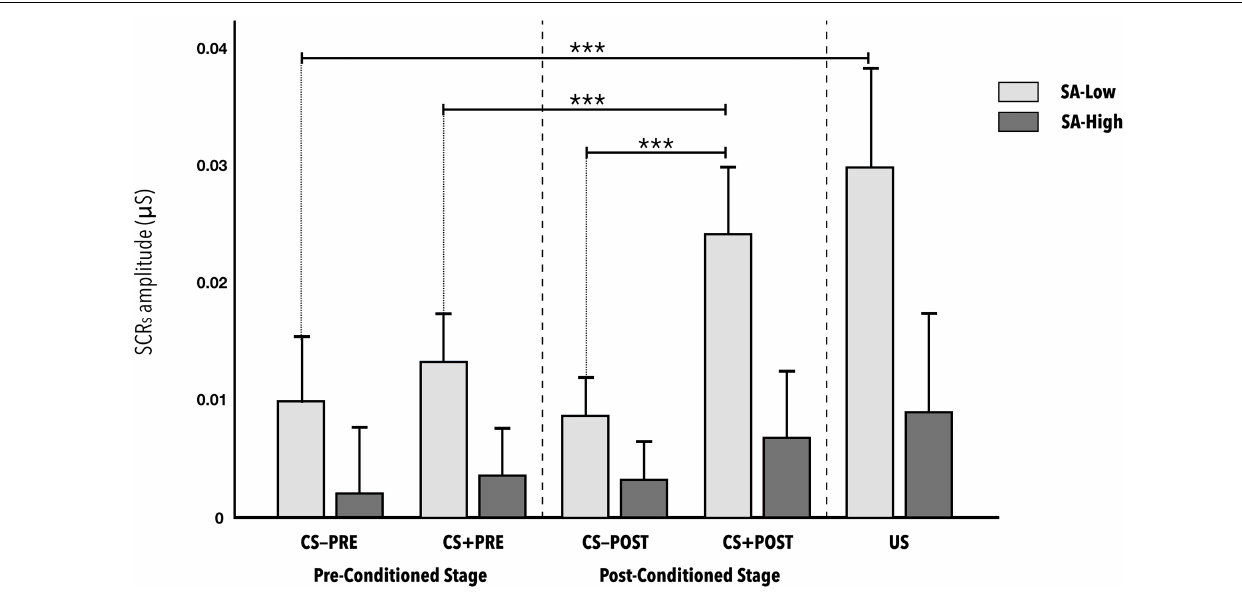
FIGURE 2 | Mean amplitudes of skin conductance responses to the CS − , CS+, and US stimuli during the vicarious phase of the fear conditioning paradigm, according to reported level of state anxiety. CS − and CS+ responses are distinguished as either before (pre-conditioned stage) or after (post-conditioned stage) the US was presented. No statistically significant differences were observed between CS-PRE vs. US ( d = 0.747), between CS + PRE vs. CS + POST ( d = 0.639), or between CS-POST vs. CS + POST ( d = 1.490), indicating correct conditioning in the SA-Low group. The error bars show standard error. Significance levels p < 0.001 are represented with ***.